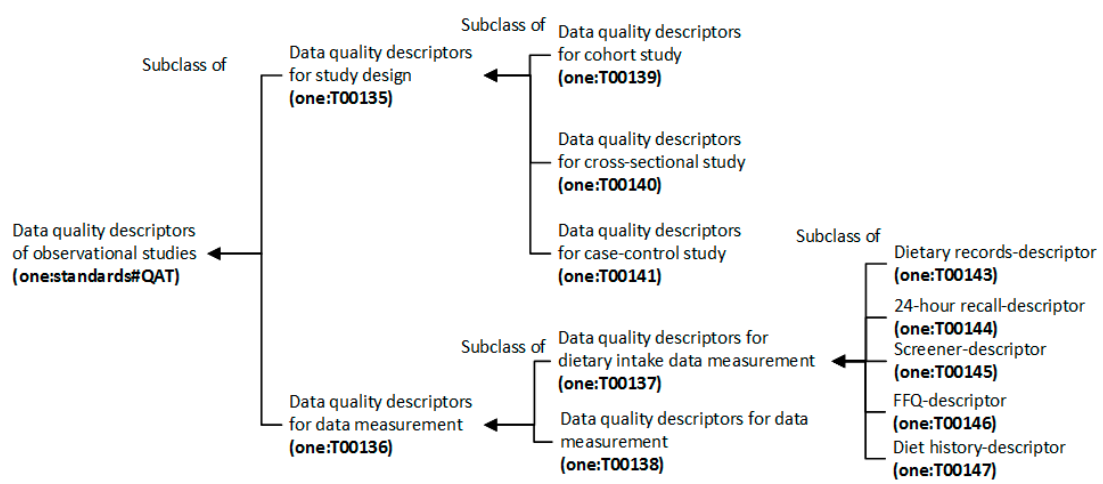
Figure Figure 4. The ontology taxonomy of data quality descriptors of observational studies in nutritional epidemiology.